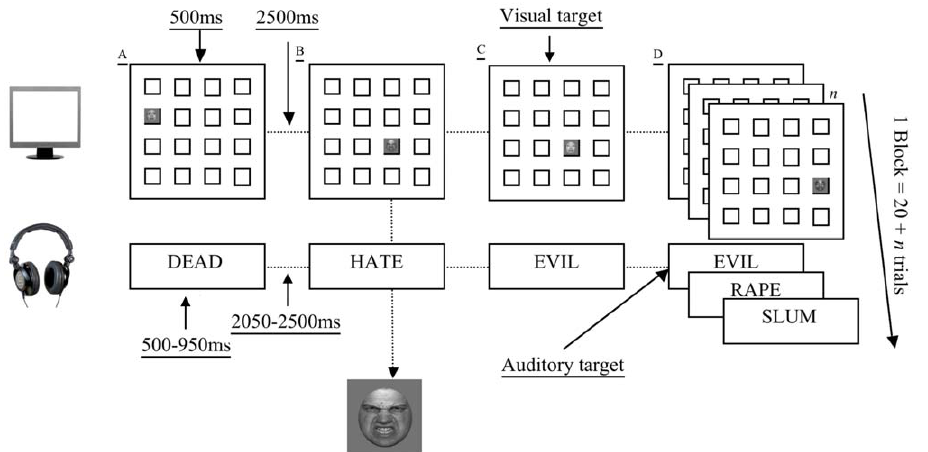
Figure 1. Emotional dual n-back block ( n =1). The figure depicts a block of the emotional version of the dual n -back task (training task) where n =1. The top row shows the sequence across trials (A, B, C, D, etc.) of visually presented stimuli in a 4 6 4 grid (the visual stimuli were presented on a standard 1280 6 1024 pixel computer display). A picture of a face appeared in one of the 16 possible grid positions on each trial. Simultaneously, with the presentation of these visual stimuli on the computer display, participants heard words over headphones (second row in the figure). Participants were required to indicate, by button press, whether the trial was a ‘target trial’ or not. Targets could be visual or auditory. In the example here, Trial C is a visual target. That is, the face in Trial C is presented in the same location as the face in Trial B (i.e., n =1 positions back). Note, the faces are of different actors. For visual stimuli participants were asked to ignore the content of the image and solely attend to the location in which the images were presented. In the current example, Trial D was an auditory target trial because ‘Evil’ is the same word as the word presented in Trial C - n positions back (where n =1). Each block consisted of 20 + n trials.